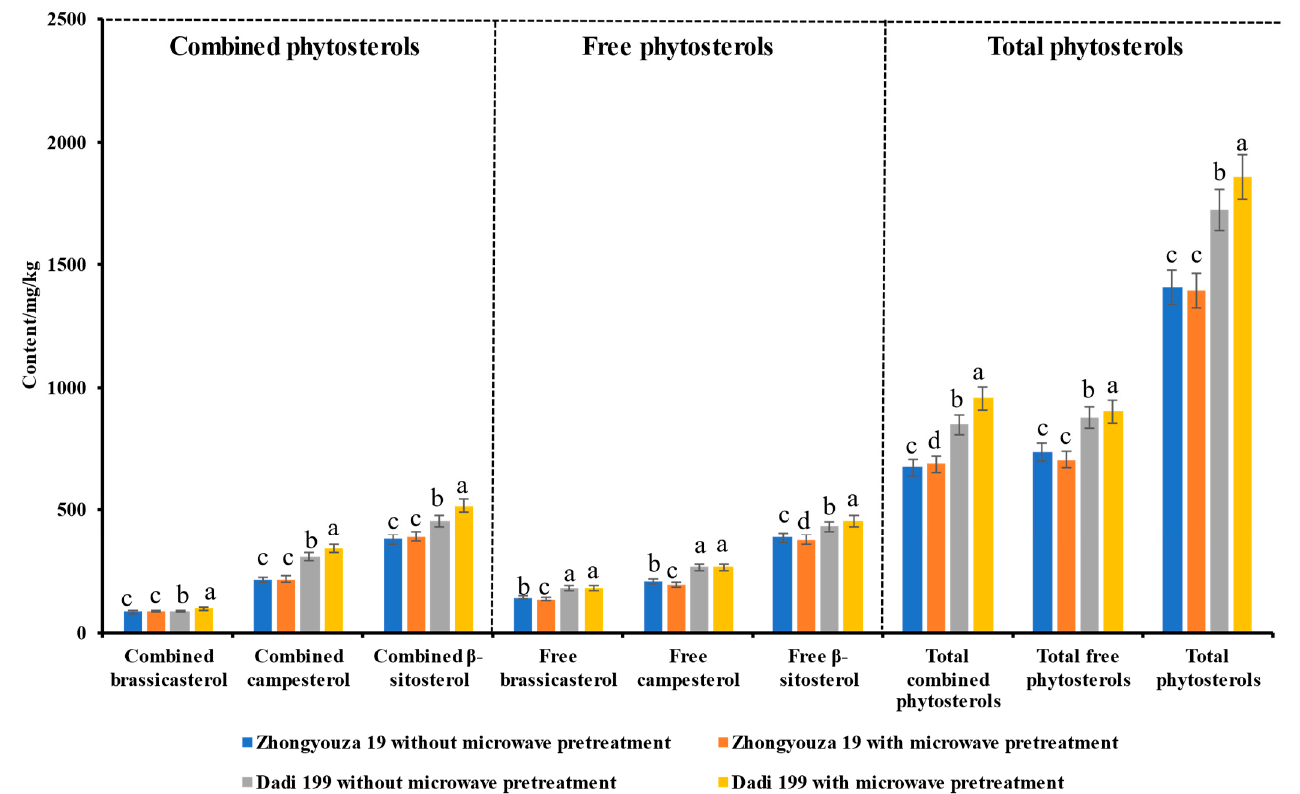
Figure 7. Effects of microwave pretreatment on the composition and content of phytosterols in rapeseed cake. Values are the means ± standard deviations; n = 3 parallel determinations. a–c Mean values (a > b > c, corresponding to the same parameter) not followed by a common letter differ significantly ( p < 0.05).